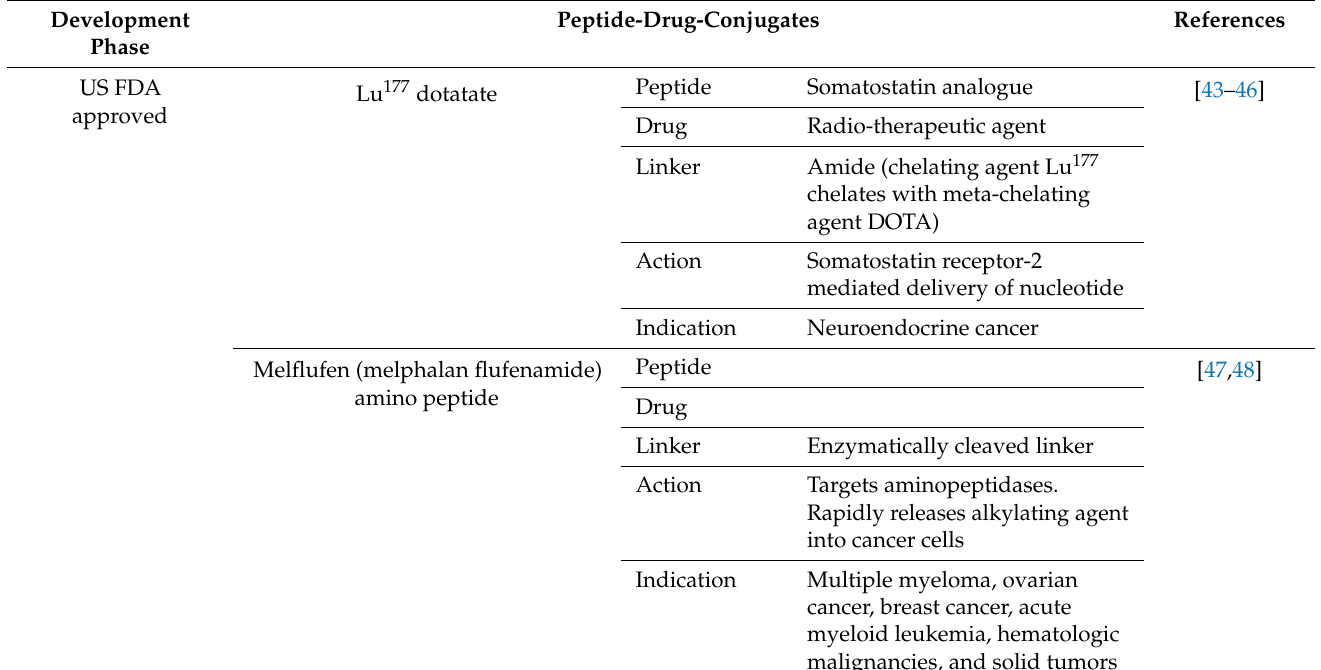
Table 1. Some peptide-drug conjugates against cancer in different developmental phases.